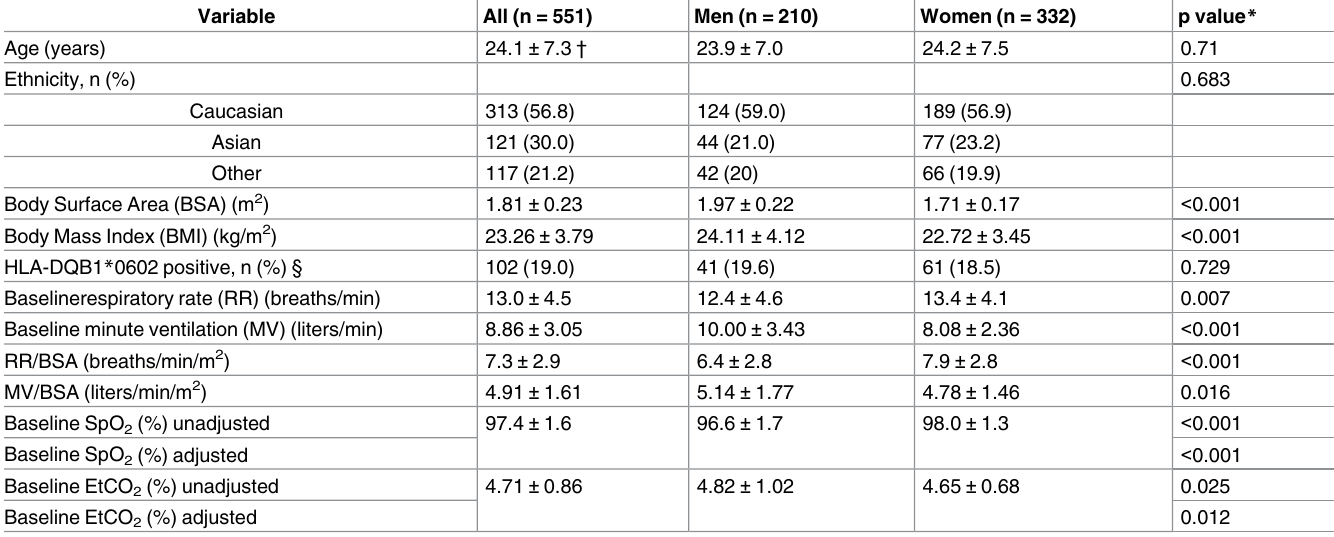
Table 1. Baseline epidemiologic and physiologic